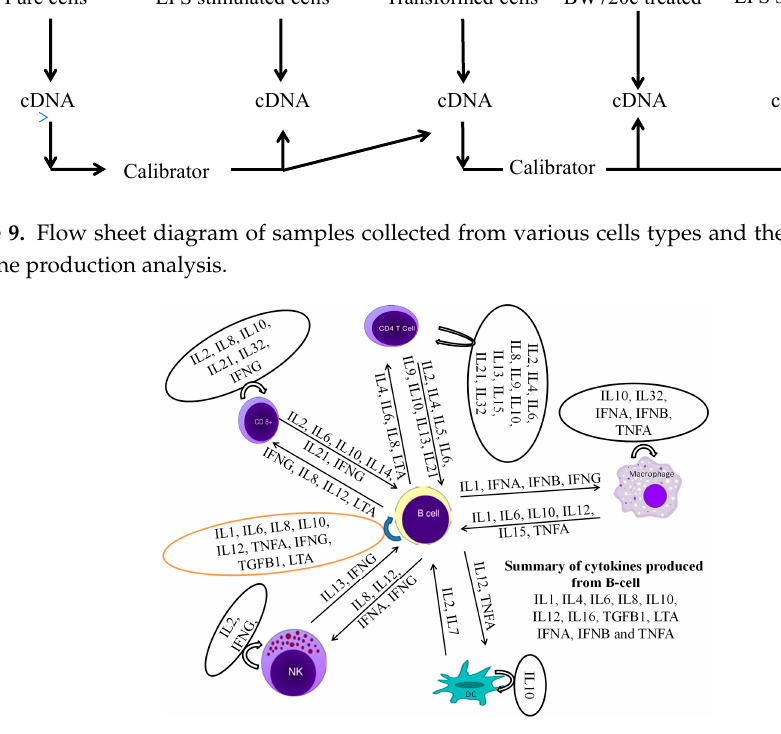
Figure 10. A cytokine production network as well as interaction with themselves and other leukocytes is required for the stimulation of B cells to produce their own cytokines.